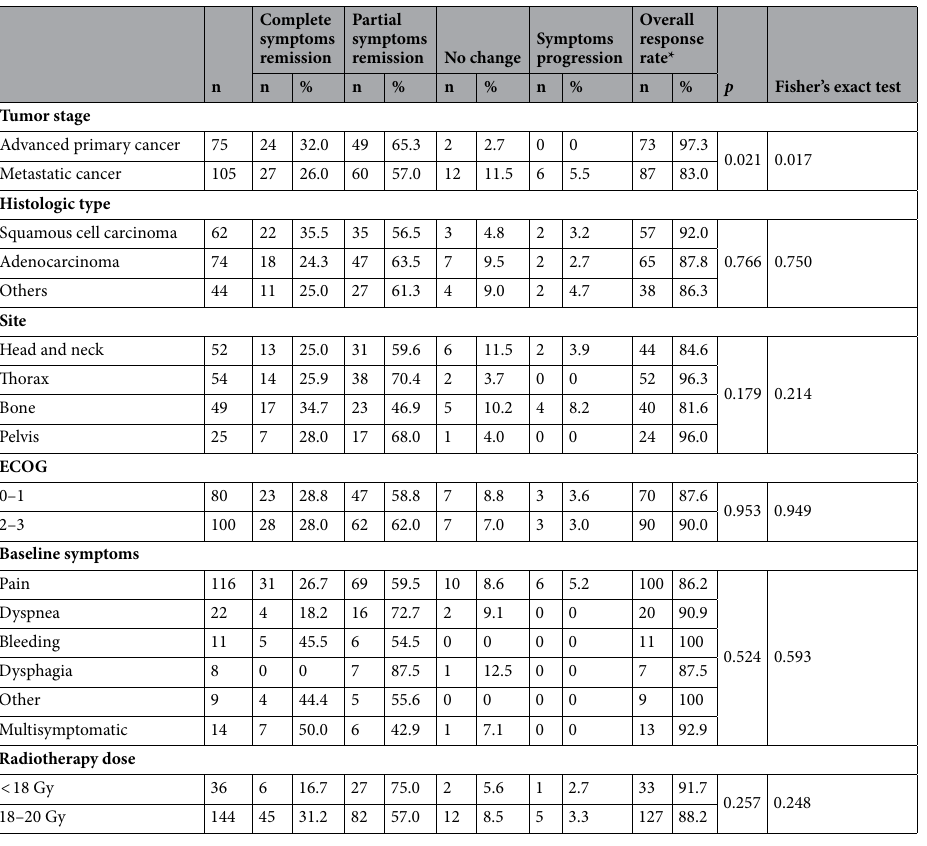
Table 1. Symptomatic response and univariate analysis. ECOG-PS: Eastern Cooperative Oncology Group- Performance Status. *Complete plus partial